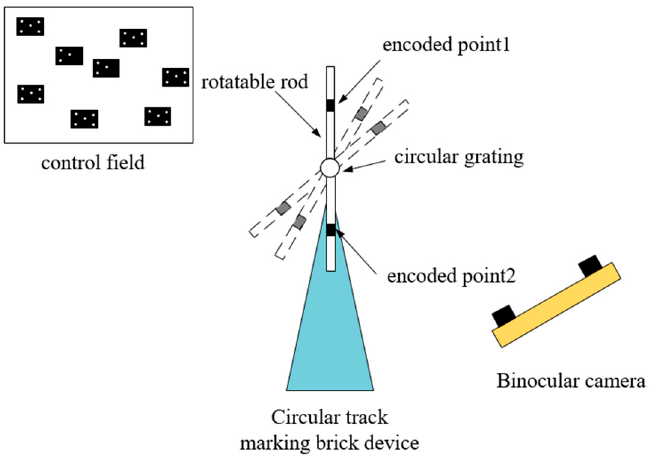
Figure 1. Calibration system’s schematic diagram.